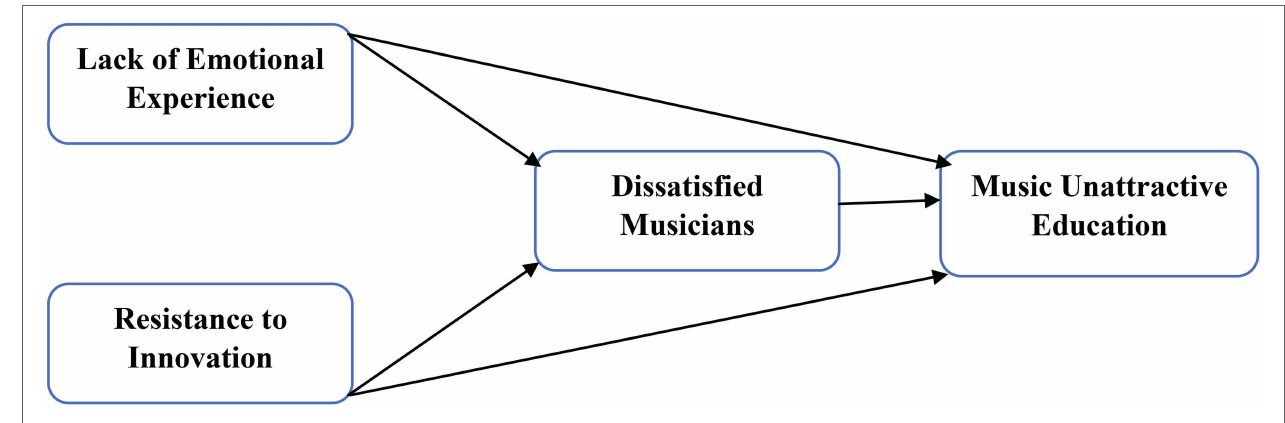
FIGURE 1 | Research model.